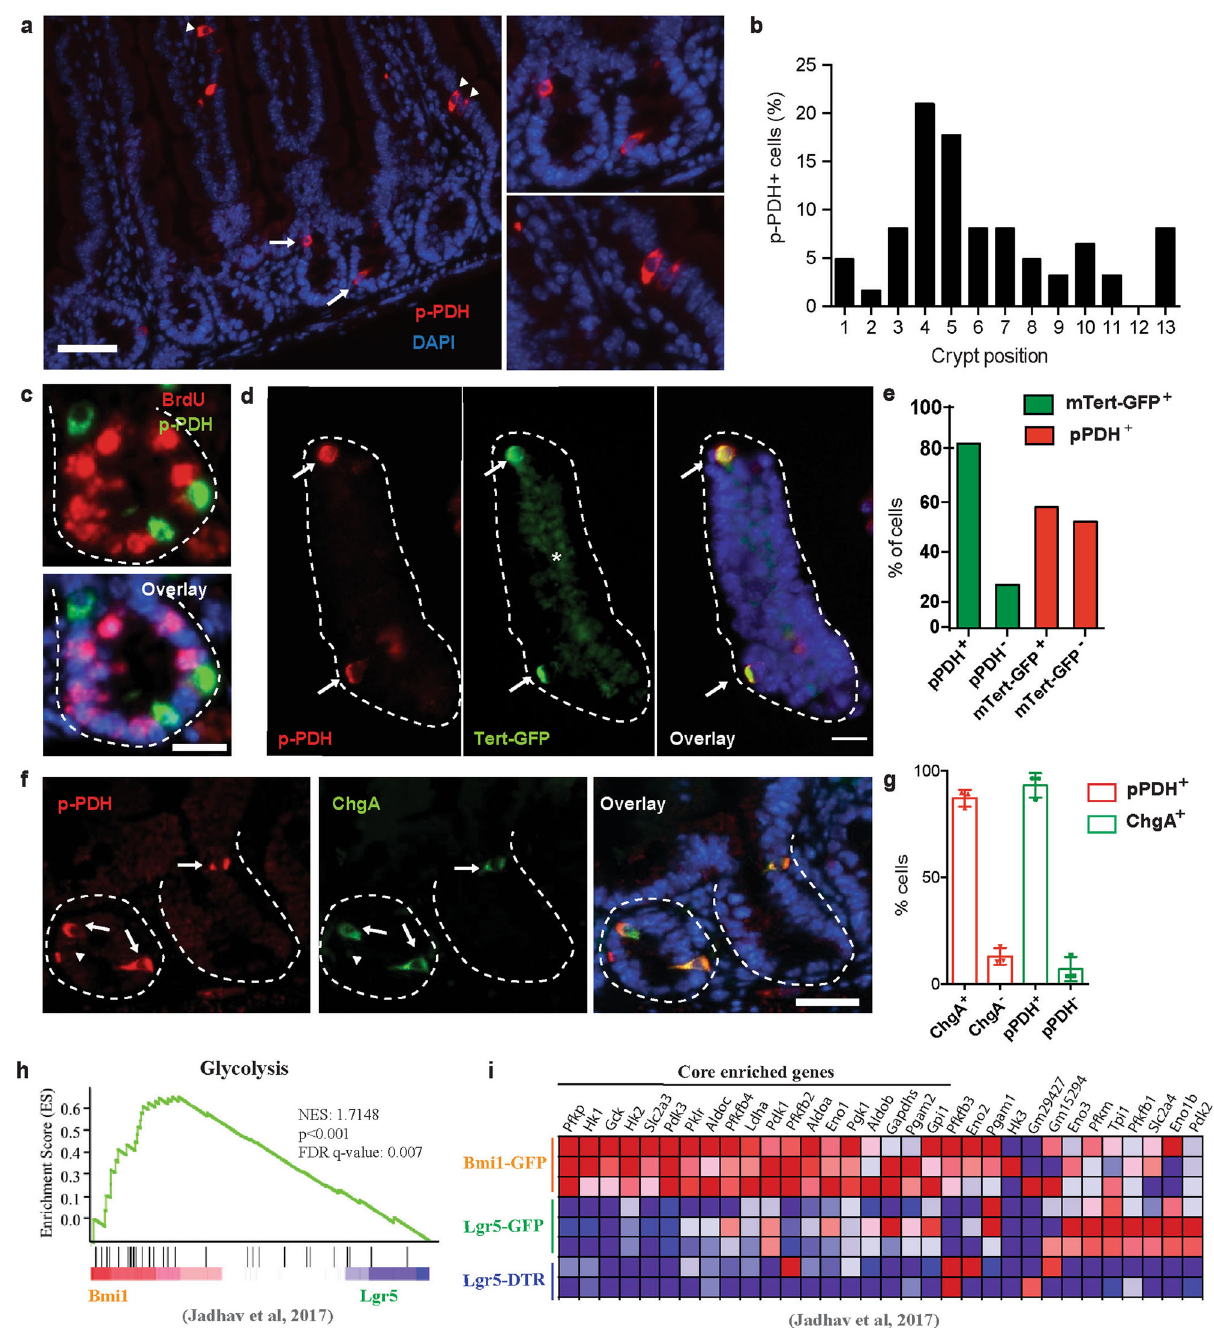
Fig. 2 High PDK activity de fi nes + 4 ISCs from EE lineage. a Immuno fl uorescence of pPDH in small intestinal sections. pPDH + cells are present in both crypts (arrows) and villi (arrowheads). On the right, magni fi cation of intestinal crypts and villi containing pPDH + cells. Scale bar, 100 μ m. b Percentage of pPDH + cells in every crypt position (62 pPDH + cells form four mice were scored). c Double immuno fl uorescence for pPDH and BrdU. Representative image of four different mice is shown. Scale bar, 25 μ m. d pPDH immuno fl uorescence on isolated crypts from mTert-GFP mice. Arrows mark pPDH + mTert + cells. Asterisk marks non-speci fi c fl uorescence signal. Scale bar, 50 μ m. e Quanti fi cation of pPDH + , mTert + , and pPDH + mTert + cells in the intestinal crypts form three mTert-GFP mice. A total of 68 crypts were scored. f Double immuno fl uorescence for pPDH and ChgA on intestinal sections. Arrows indicate double positive cells, arrowheads indicate pPDH + ChgA − cells. Scale bar, 50 μ m. g Quanti fi cation of pPDH + , ChgA + , and pPDH + ChgA + cells on intestinal sections from three mice (at least 50 crypts/mouse were scored). Data are presented as mean ±SEM. h Gene set enrichment analysis of positive regulators of glycolysis in Bmi1-GFP cells compared to Lgr5 ISCs from Lgr5-GFP and Lgr5-DTR mice (Jadhav et al. 20 ). i Heat map of the glycolytic gene signature from ( a ) showing the core enriched genes. Source data are provided as a Source Data fi